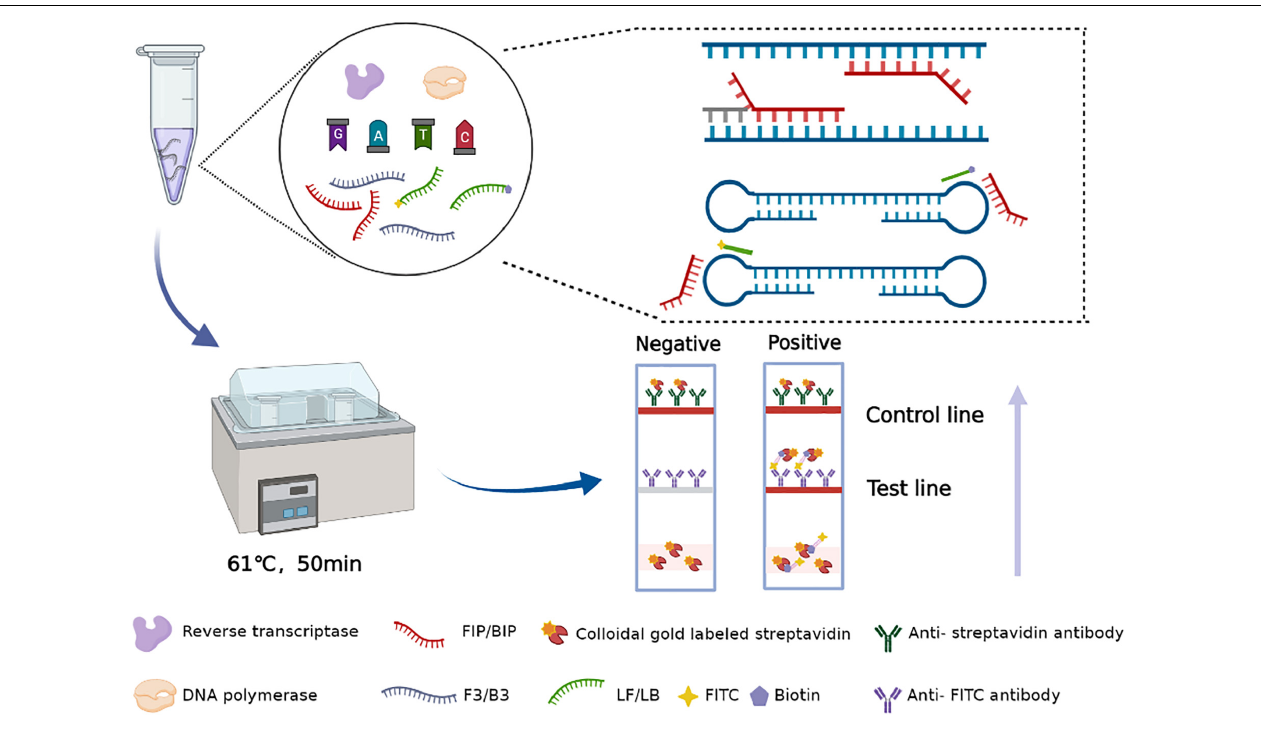
FIGURE 2 | Schematic illustration of the RT-LAMP-VF assay targeting the SARS-CoV-2 N gene. TABLE 7 | The sensitivity and specificity of the RT-LAMP-VF assay were evaluated in viral RNA specimens. The RT-LAMP-VF assay panel Two gold standard real time RT-PCR assays Sensitivity Specificity Concordance rate (%) Positive samples ( N = 11) Negative samples ( N = 20) Concordance rate (95% CI)